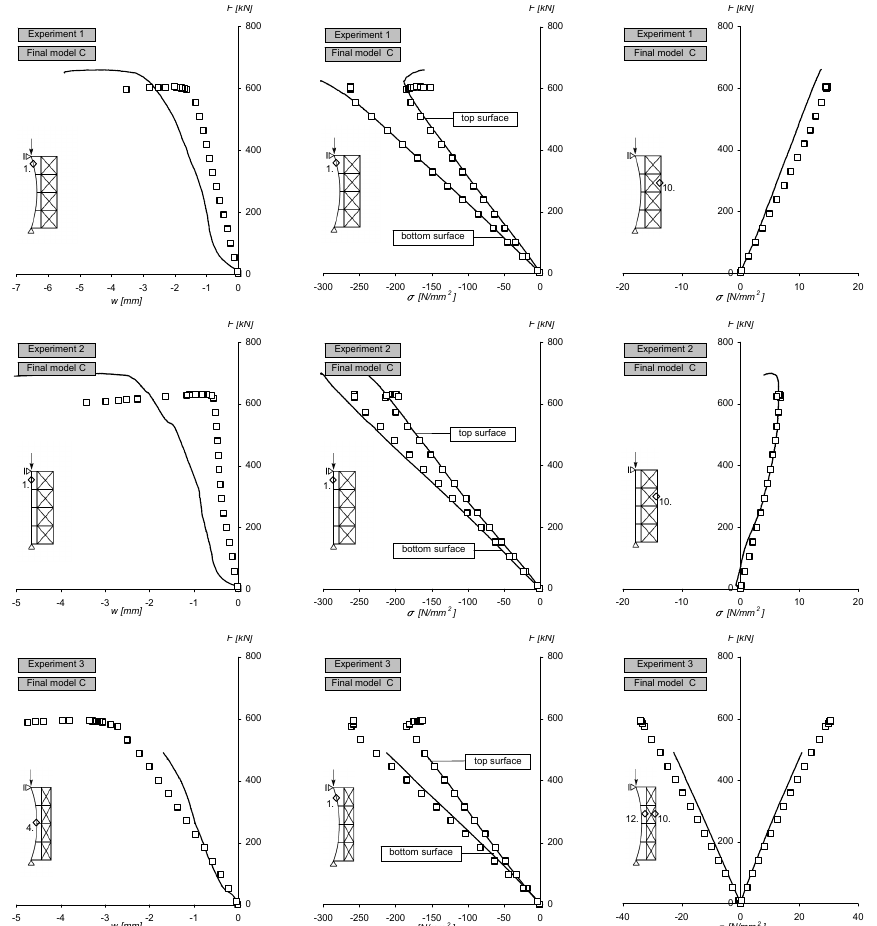
Figure 11: Experimental (solid lines) and numerical (box markers) results. Load-deformation graphs of the steel column at location of maximum lateral deformation; load-stress graphs of the steel column at location of maximum bending; load-stress graphs of the glass pane at location of maximum bending (i.e., edges). The measurement locations are indicated by diamond markers and numbers corresponding to Figure